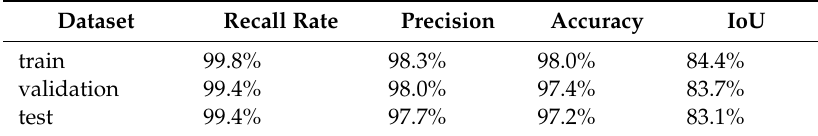
Figure 7. The recall rate, intersection over union (IoU), and loss of the train set and validation set for evaluating the trained model during the training process. Table 3. Performance of the trained excavator detection model on the train set, validation set and test